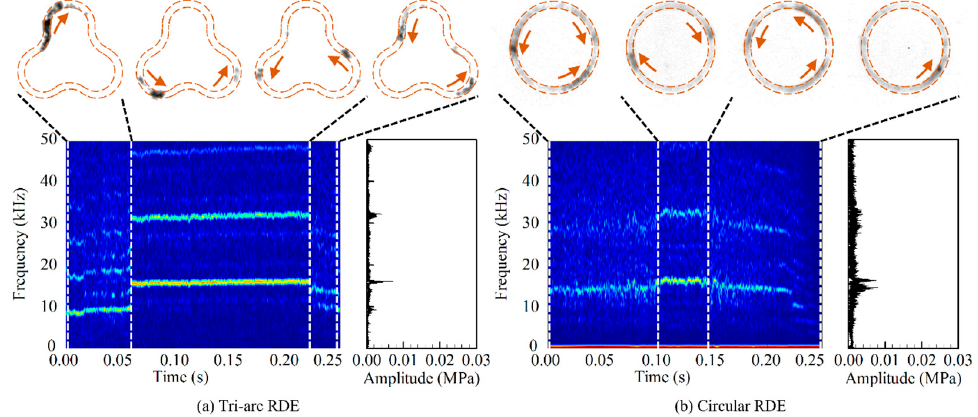
Figure 9. Experimental visualization ( upper ), STFT ( lower-left ), and FFT ( lower-right ) results at low . m = 54.3 ± 0.04 g/s for Φ = 0.9688 ± 0.00056; tri-arc ( a ) and circular ( b ) RDEs. mass flow rate, low mass flow rate, 𝑚(cid:4662) = 54.3 ± 0.04 g/s for Φ = 0.9688 ± 0.00056 ; tri-arc ( a ) and circular ( b ) RDEs.